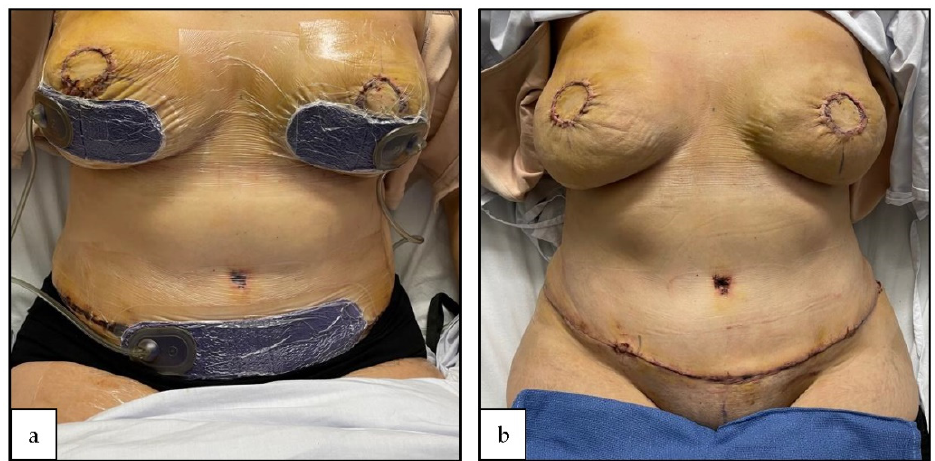
Figure 1. ( a ) Application of ciNPT dressings to abdominal donor site (and recipient sites) ( b ) ciNPT dressings removed on post-operative day 5.